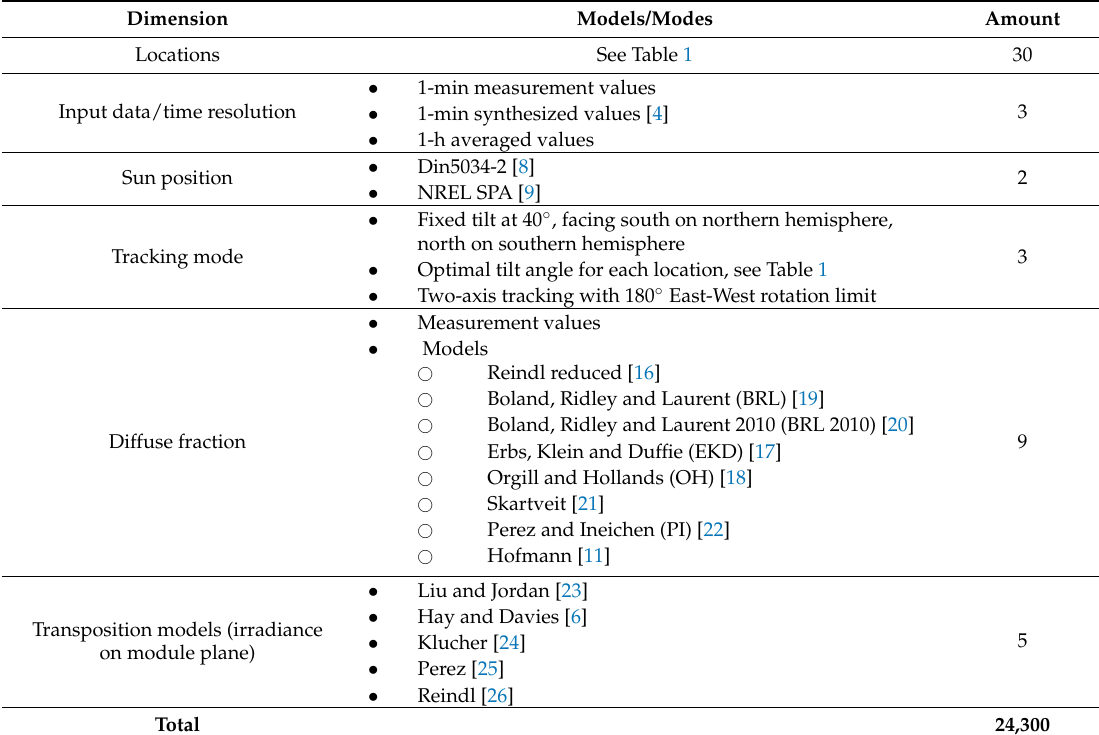
Table 2. Overview over the dimensions of the matrix